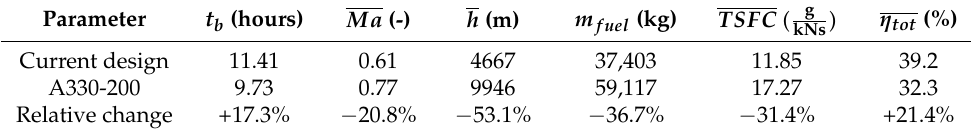
Table 3. Performance data of current design and A330-200 for reference